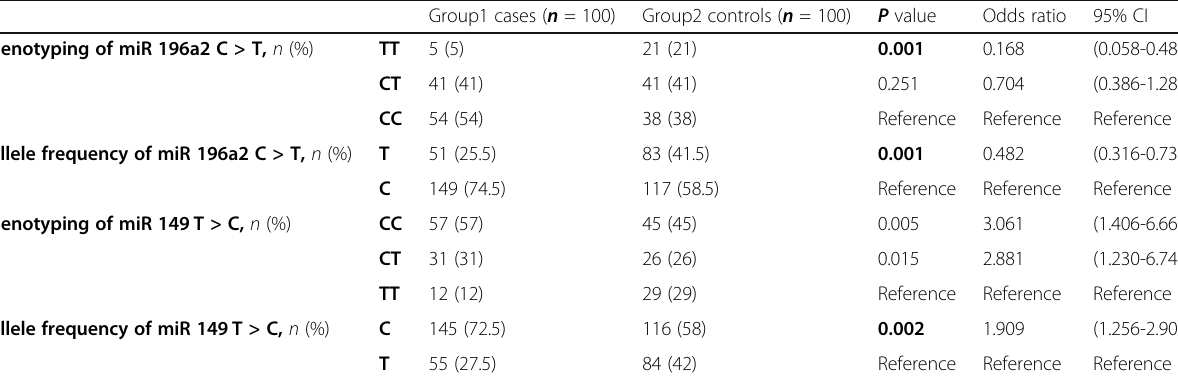
Table 2 Genetic characteristics of the studied groups